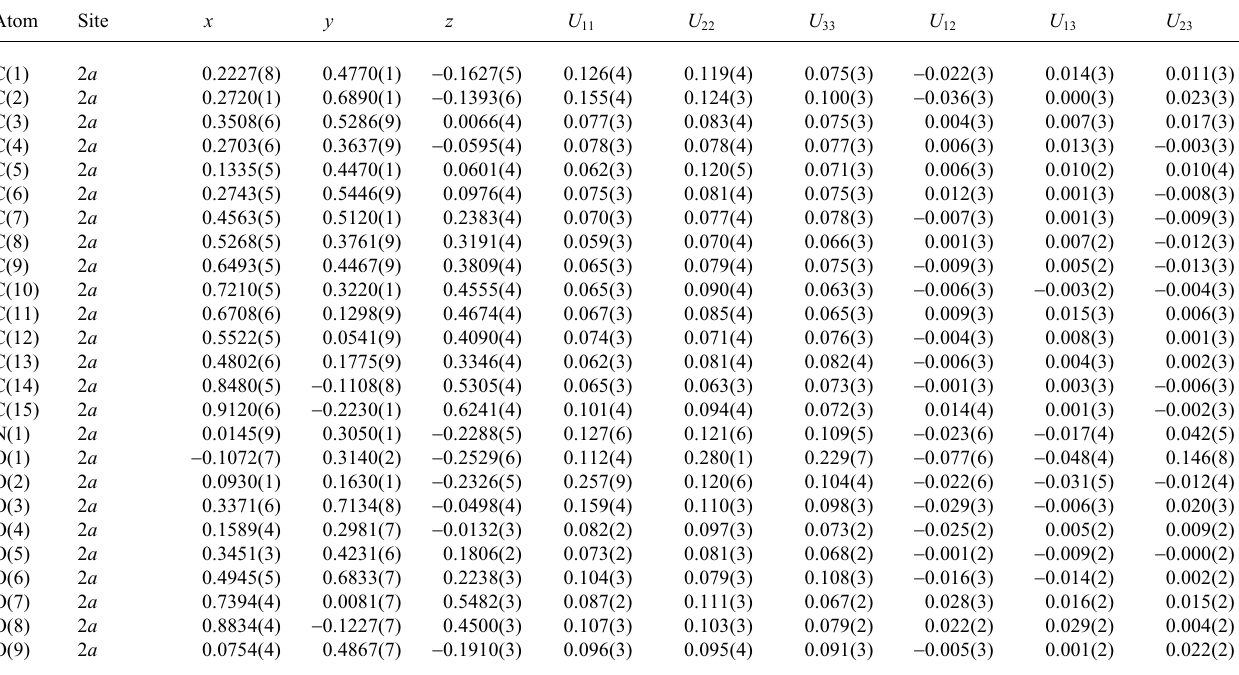
Table 3. Atomic coordinates and displacement parameters (in Å 2 )